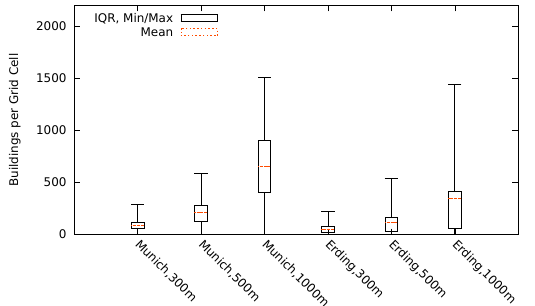
Figure 11: Number of buildings contained in grid cells with varying side length in Munich and Erding.